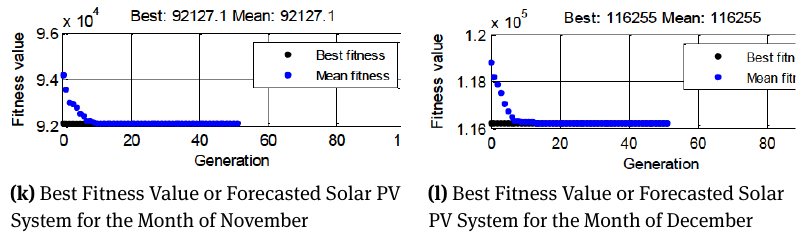
Figure 3: Shows the Best Fitness Value or Forecasted Solar PV System for the every month of